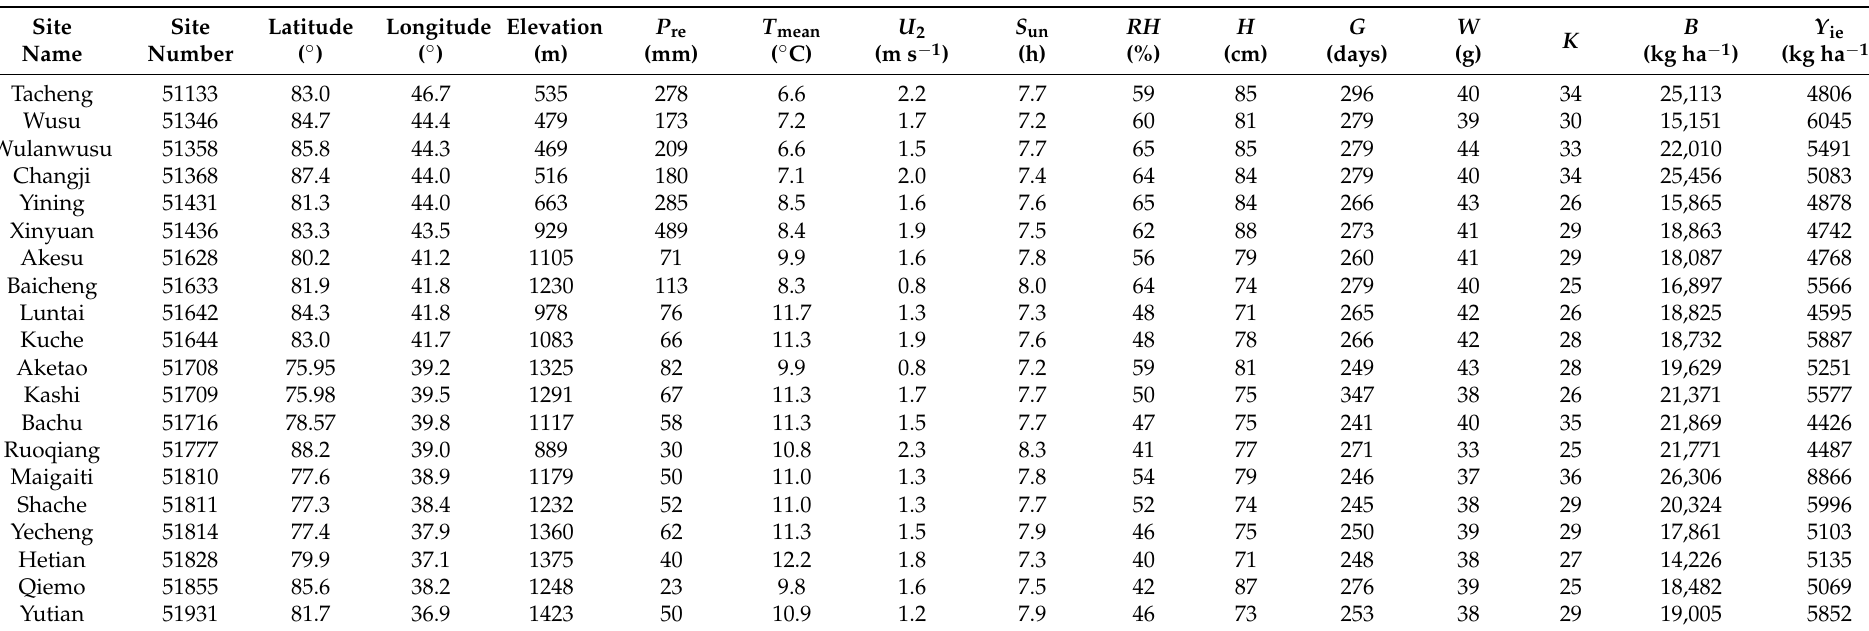
Table 1. The geographical information and the long-term mean values of P re , T mean , U 2 , S un , RH and yield-related variables include plant height ( H ), growth period ( G ), 1000-kernel weight ( W ), kernel number per ear ( K ), biomass ( B ) and yield ( Y ie ) over 1981–2017 during the winter wheat growth period at the 20 ago-meteorological stations in Xinjiang,